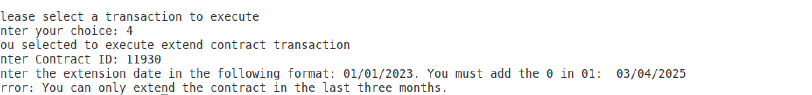
Figure 8. An employer peer issues the “ExtendContract” transaction, which fails due to the violation of one of the employment contract terms.